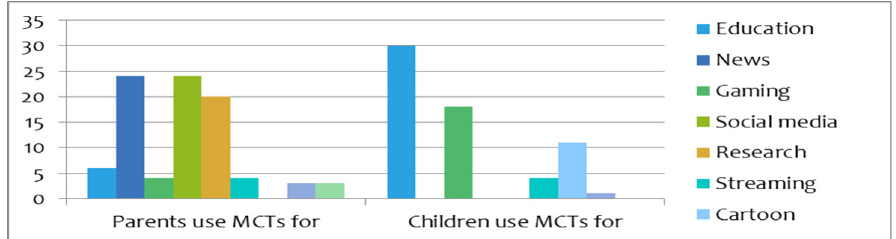
Figure 2: Why Parents and Children Use